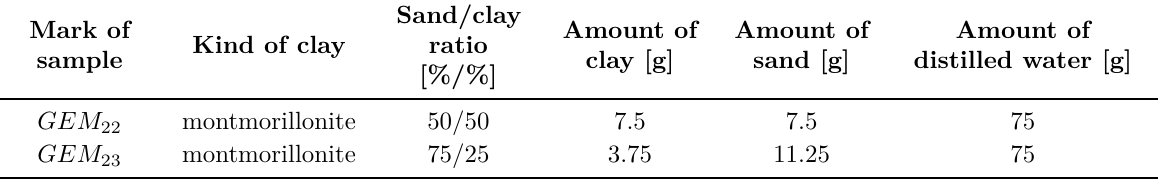
Table 2. Composition of earth samples for the measurement where shorter stirring time then 1 minute is used for each 1 ml of MB solution in earth samples.